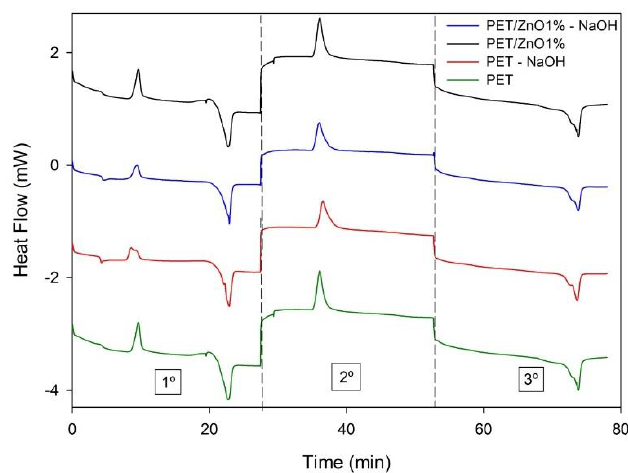
Figure 3. DSC scans of the whole thermal cycle—first heating (1 ◦ ), cooling (2 ◦ ), and second heating (3 ◦ ). Compounds indicated. Heating / cooling / reheating rates of 10 ◦ C / min.